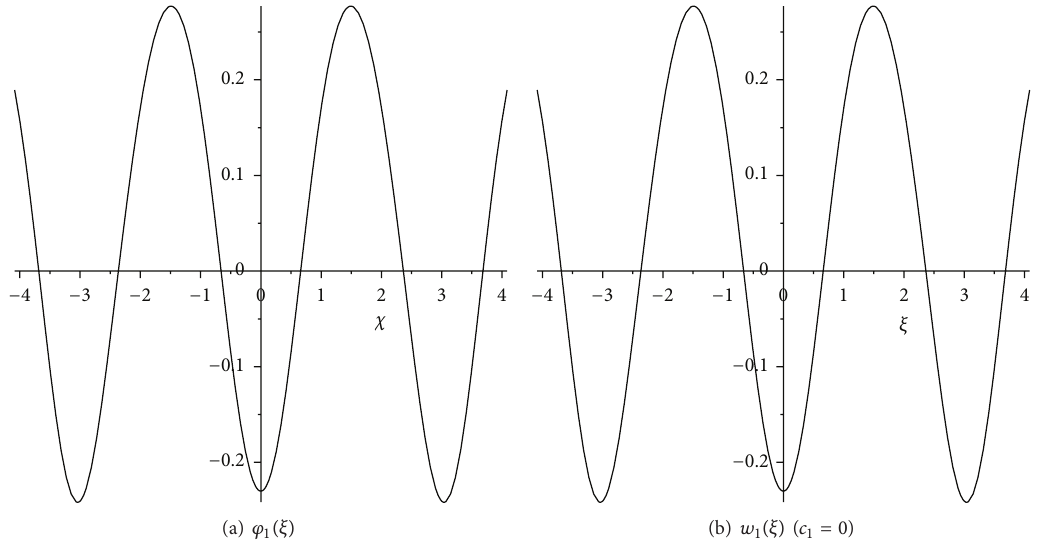
Figure 4: The periodic wave solutions of the system (11) and the system (3) when 𝑟 < −4√3𝑘𝑐/3 , 𝑘 > 0 , 𝑐 > 0 , and Δ ≥ 0